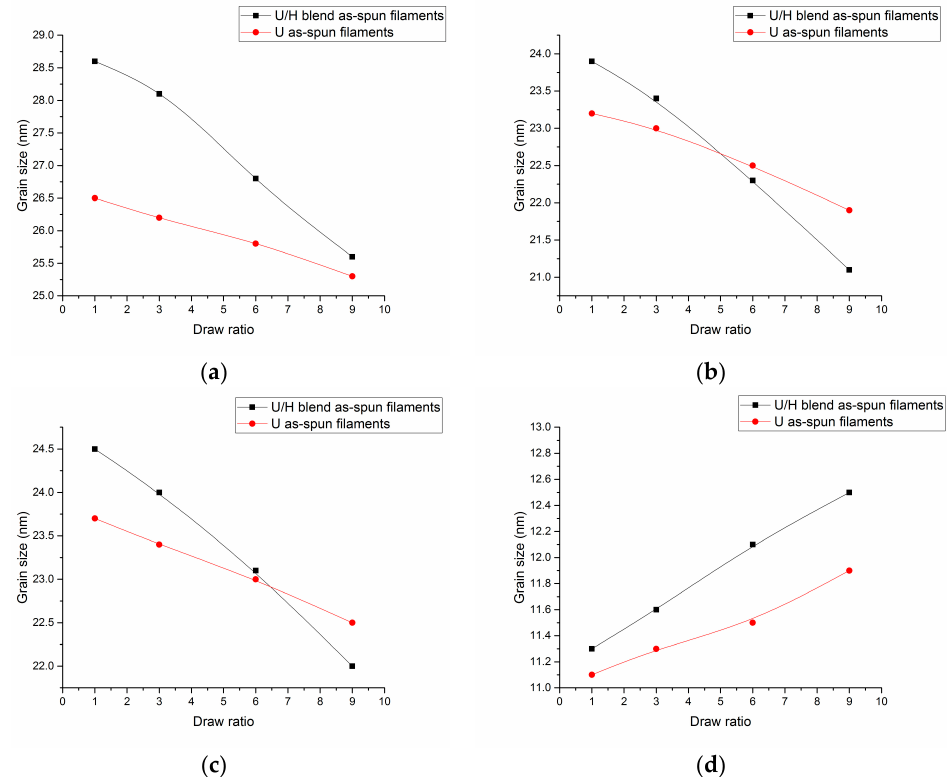
Figure 9. The grain size of the as-spun filament samples: ( a ) (110) plane; ( b ) (200) plane; ( c ) (020) plane; and ( d ) (002) plane.